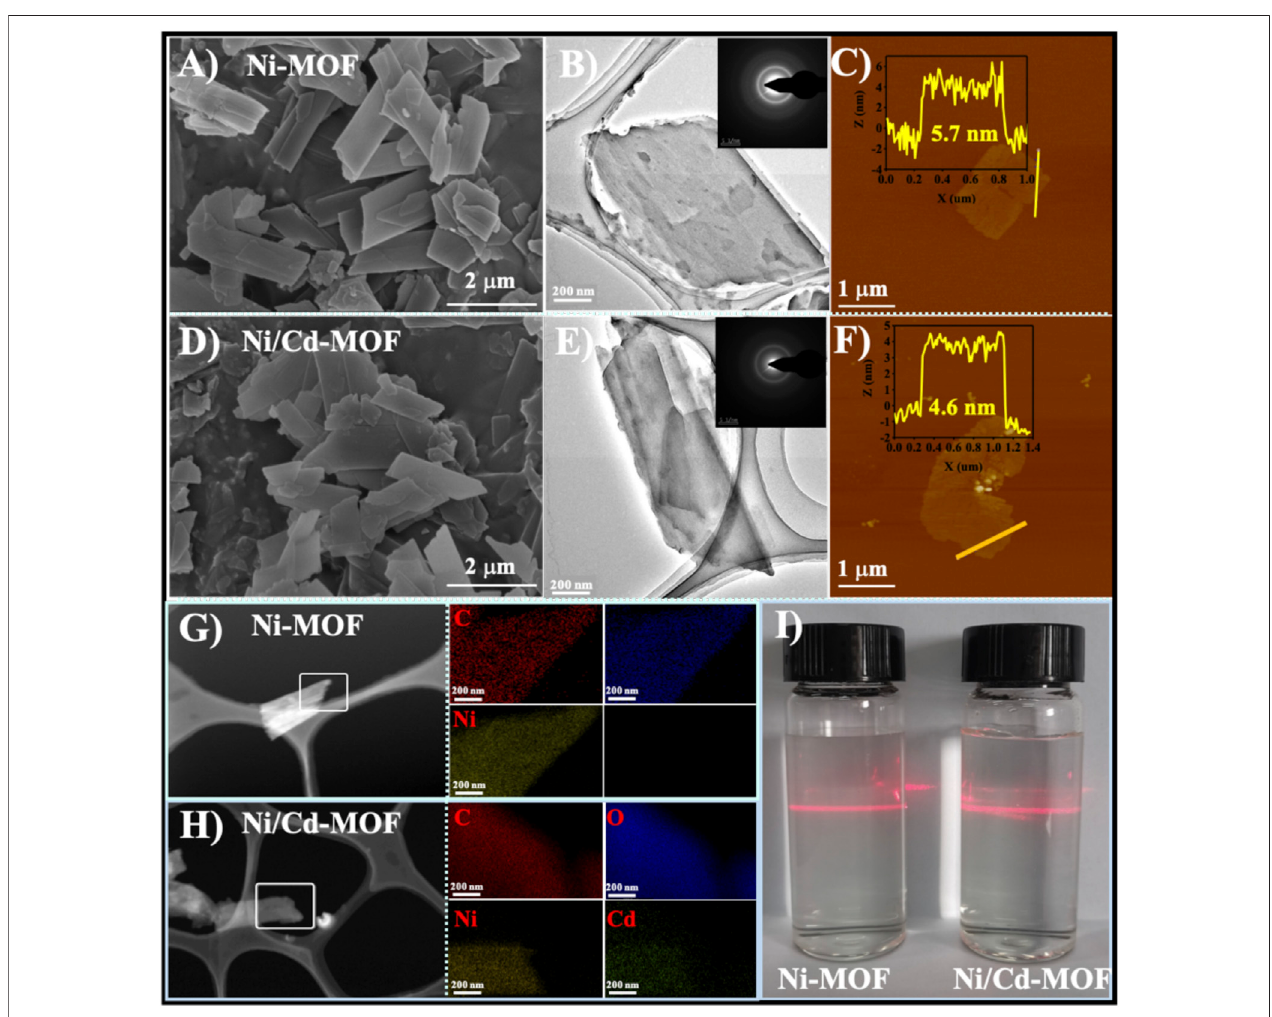
FIGURE1|(A) SEM, (B) TEM,and (C) AFMimagesofNi-MOF,theinsetisthecorrespondingSAEDpattern; (D) SEM, (E) TEM,and (F) AFMimagesofNi/Cd-MOF;STEM image and EDX elemental mappings of (G) Ni-MOF and (H) Ni/Cd-MOF; (I) Tyndall effect of Ni-MOF and Ni/Cd-MOF in aqueous